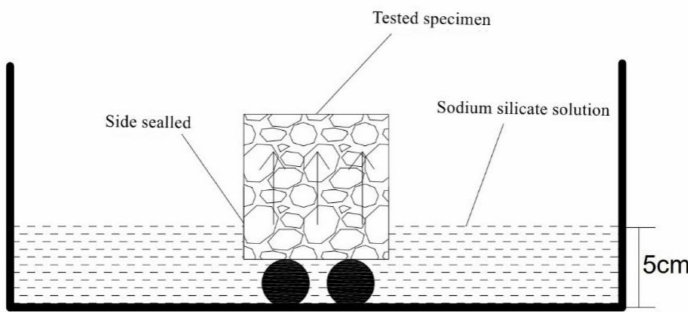
Figure 5. Capillary water absorption experiment of MSWI recycled concrete.